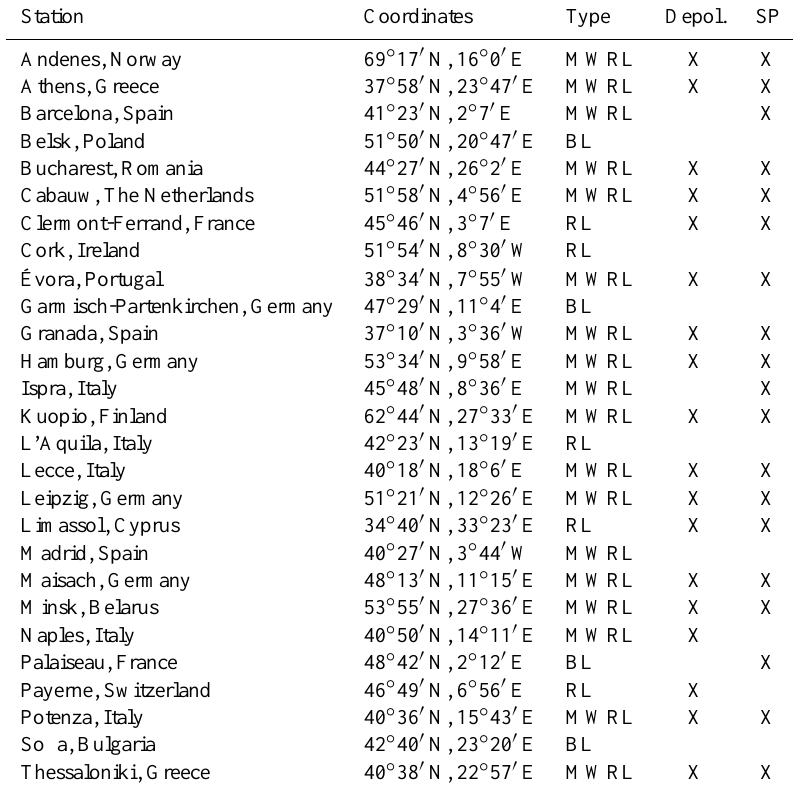
Table 1. Active EARLINET stations. Depol: aerosol depolarization-measurement capability; SP: collocated AERONET sun photometer; MWRL: multiwavelength Raman lidar; RL: Raman lidar; BL: backscatter